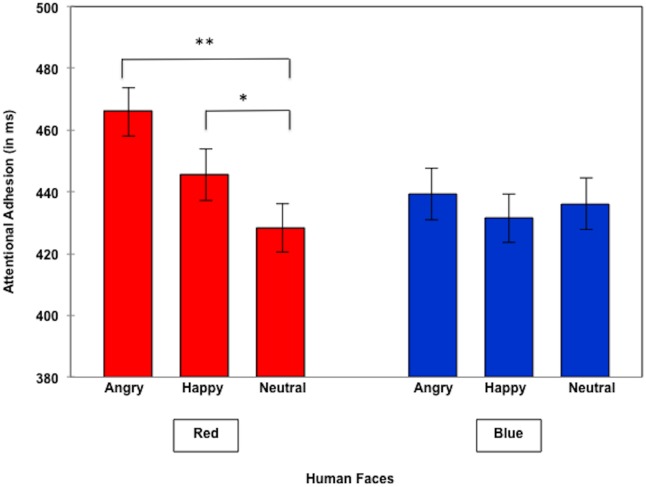
Attentional adhesion to human faces.